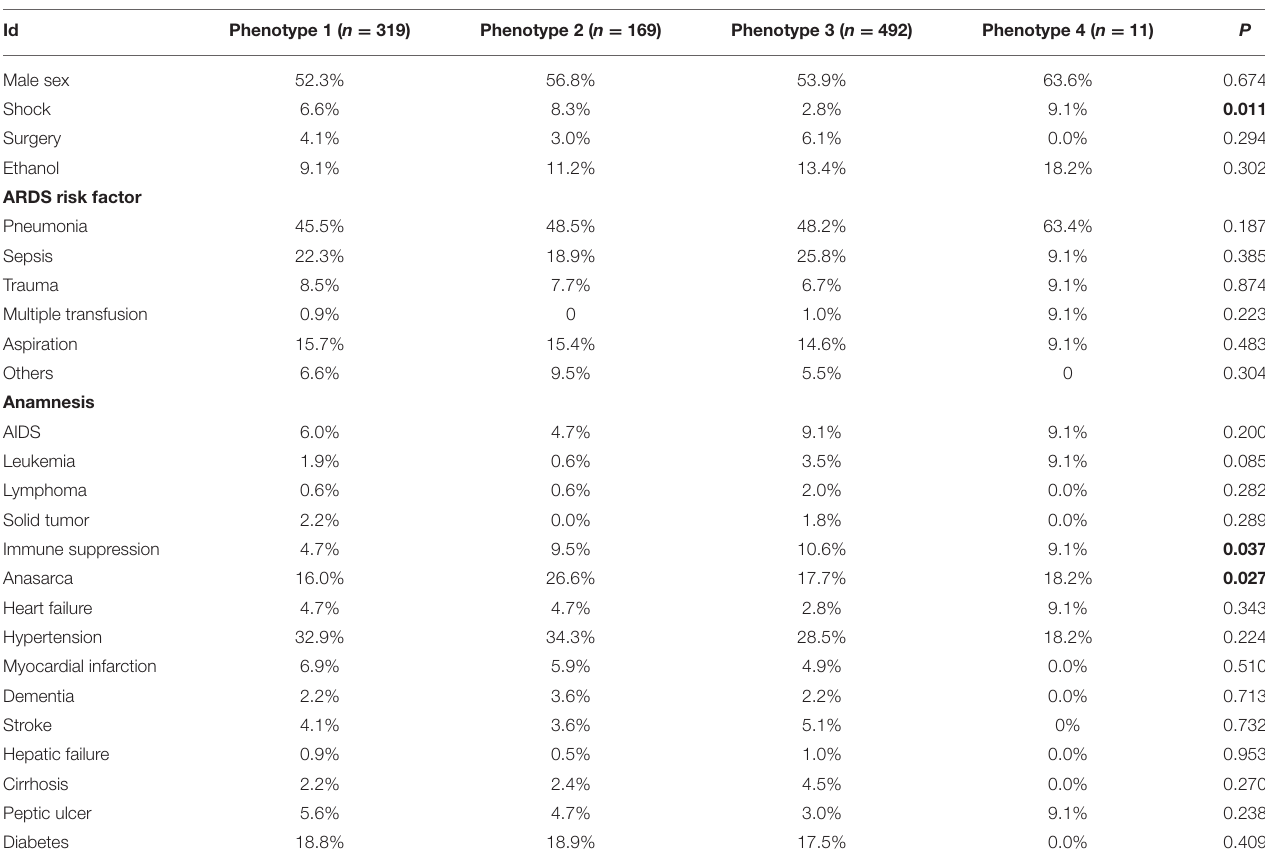
TABLE 2 | Dichotomous characteristics in different